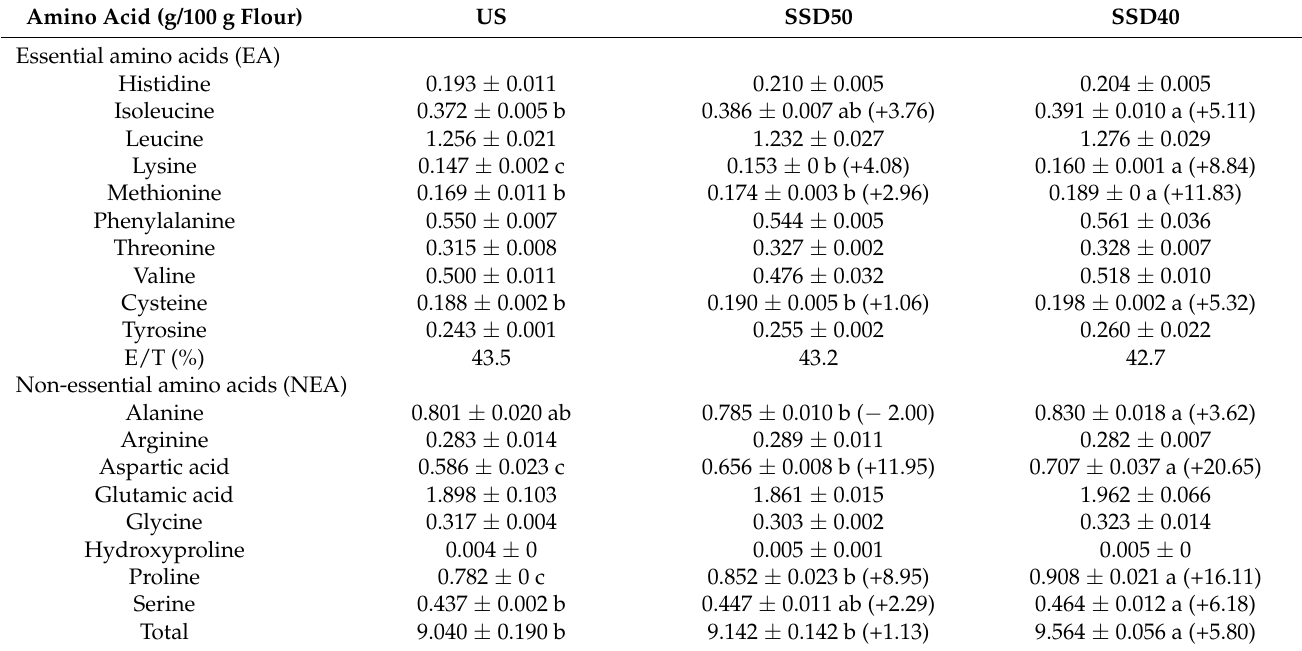
Table 2. Amino acid composition of sorghum flours expressed as g/100 g flour. In brackets, the % index of change compared to S